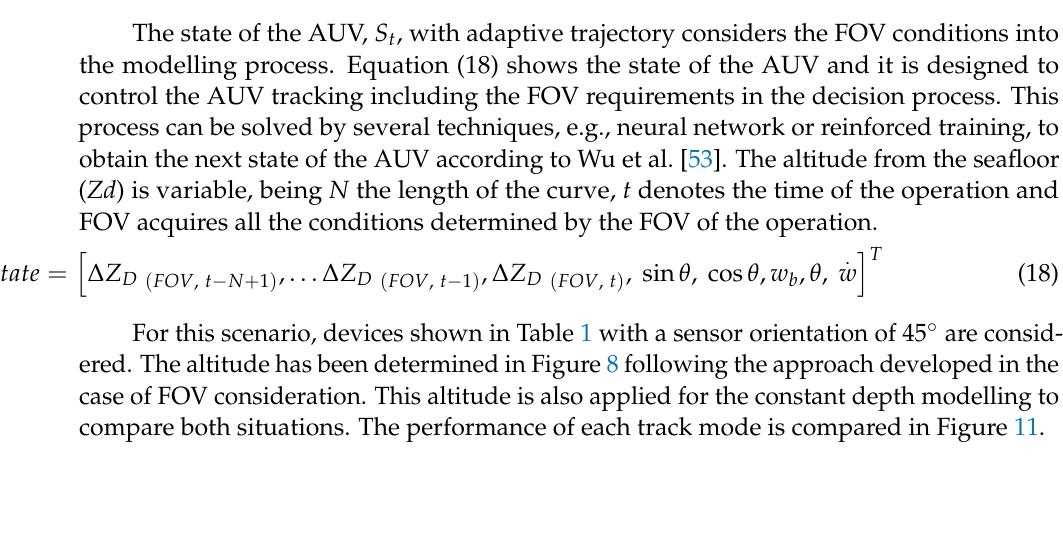
Figure 10. Evolution of MDP for depth tracking considering the